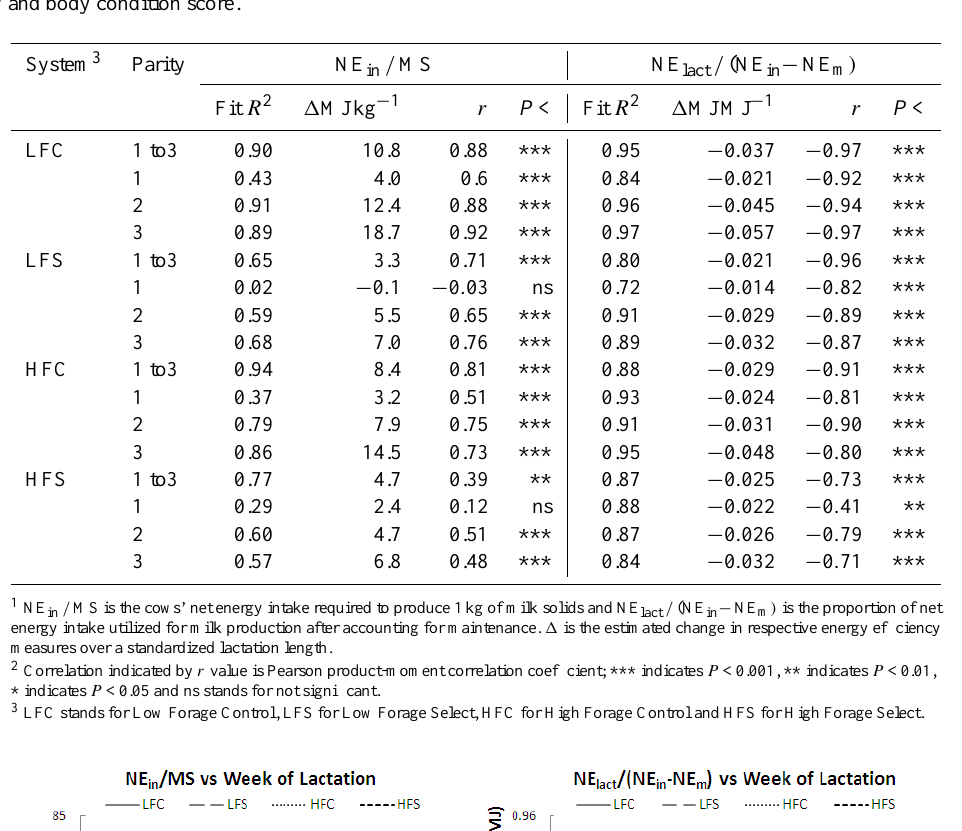
Table 4. R 2 value of fitted polynomial lines, change in the biological energy efficiency 1 over a lactation, and correlation 2 between biological energy efficiency and body condition score.